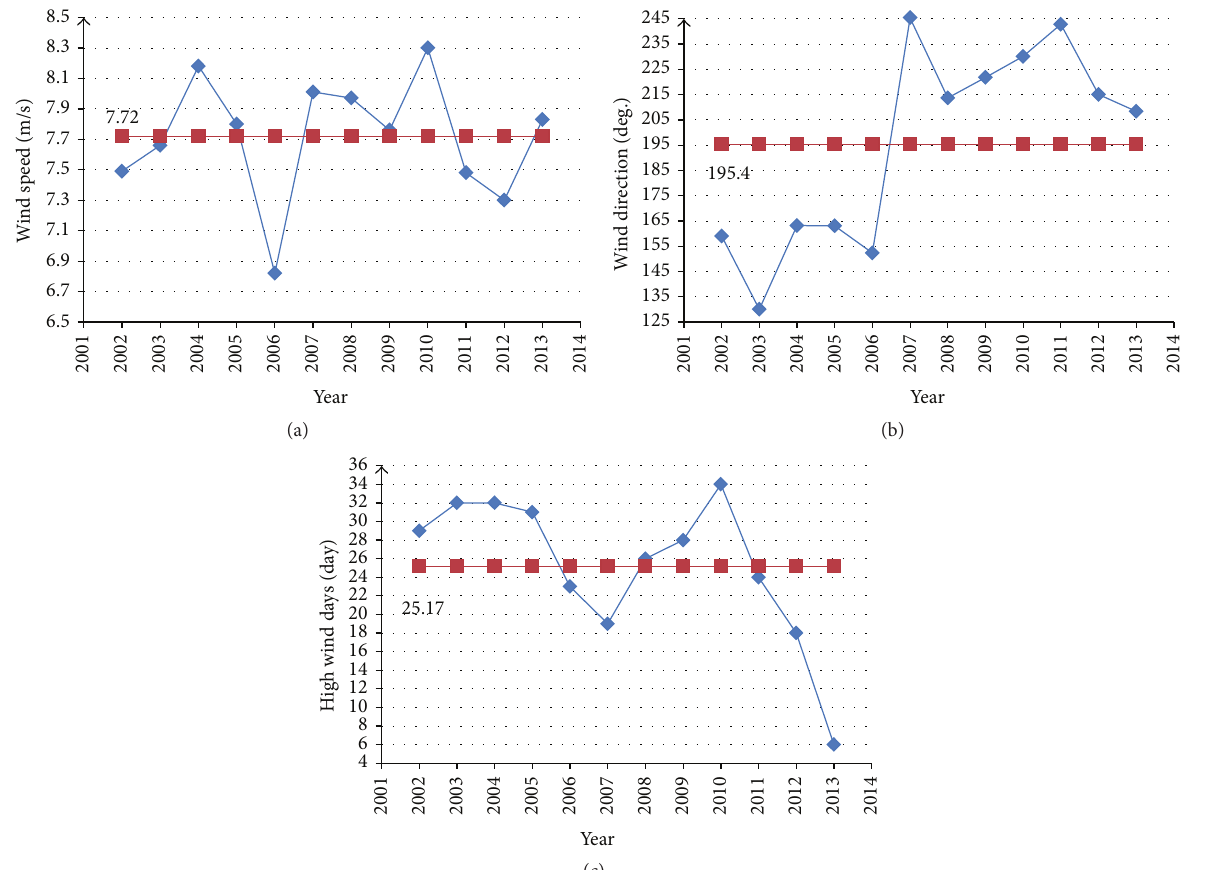
Figure 8: Average wind field parameters in winter between 2002 and 2013. (a) 𝑉 : wind speed; (b) 𝑉